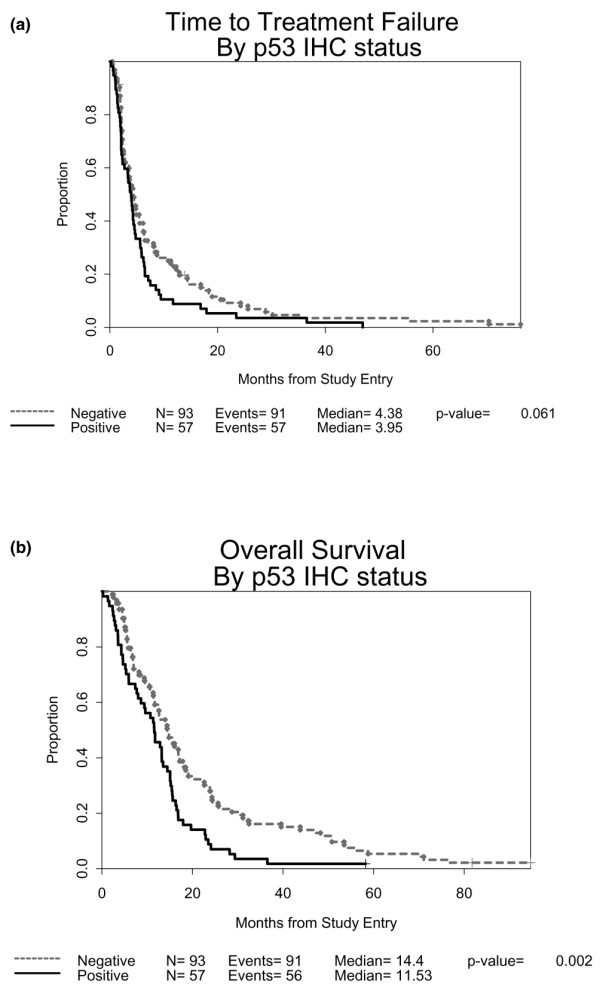
Time to treatment failure and overall survival according to p53 status, as assessed by immunochemistry. (a) Time to treatment failure and (b) overall survival. Patients were classified as p53 positive (solid line) or p53 negative (dashed line) as determined by immunochemistry with D07 antibody. A positive case is defined as ≥10% positive, localization of nuclear or nuclear and cytoplasmic, and intensity of stain weak, moderate, or intense. IHC, immunohistochemistry.